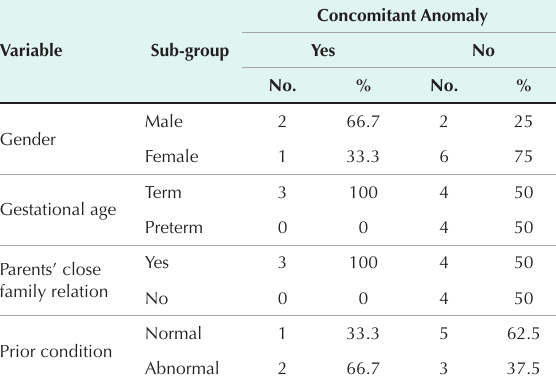
Table 5. Correlation of Anomaly and Several Qualitative Features in the Two Research Groups